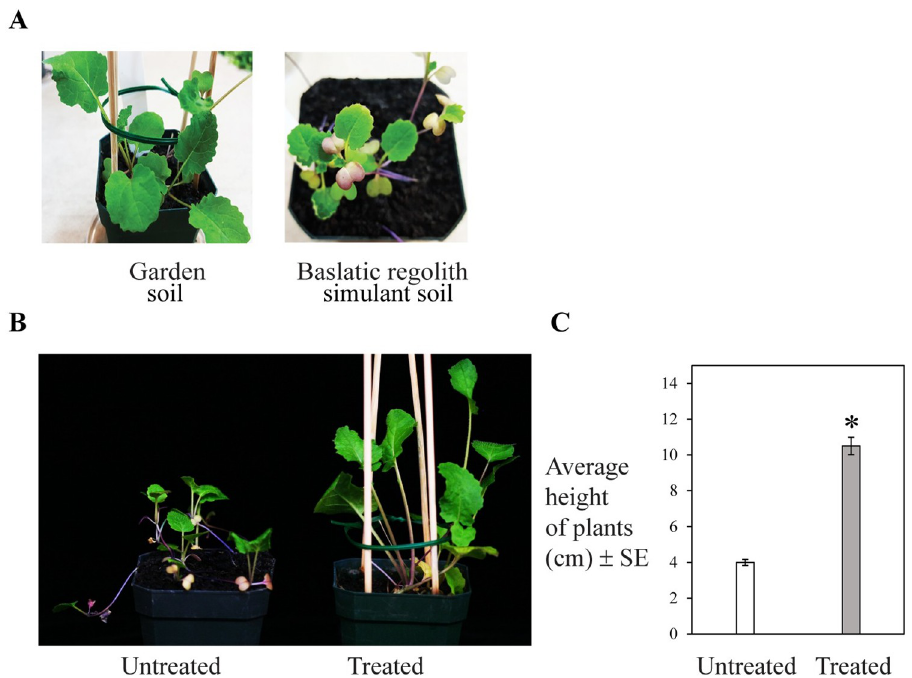
Fig 2. (A) Growth of turnip plants (after 3 weeks) in basaltic regolith simulant soil or garden soil watered with fresh water. (B and C) Growth of turnip plants (after 4 weeks) in chemical fertilizer treated or untreated basaltic regolith simulant soil watered with fresh water. Shoot height of at least 5 individual plants in each treatment was measured. Data represent average ± SE and significant difference is indicated by an asterisk (p < 0.01) as determined by paired t -